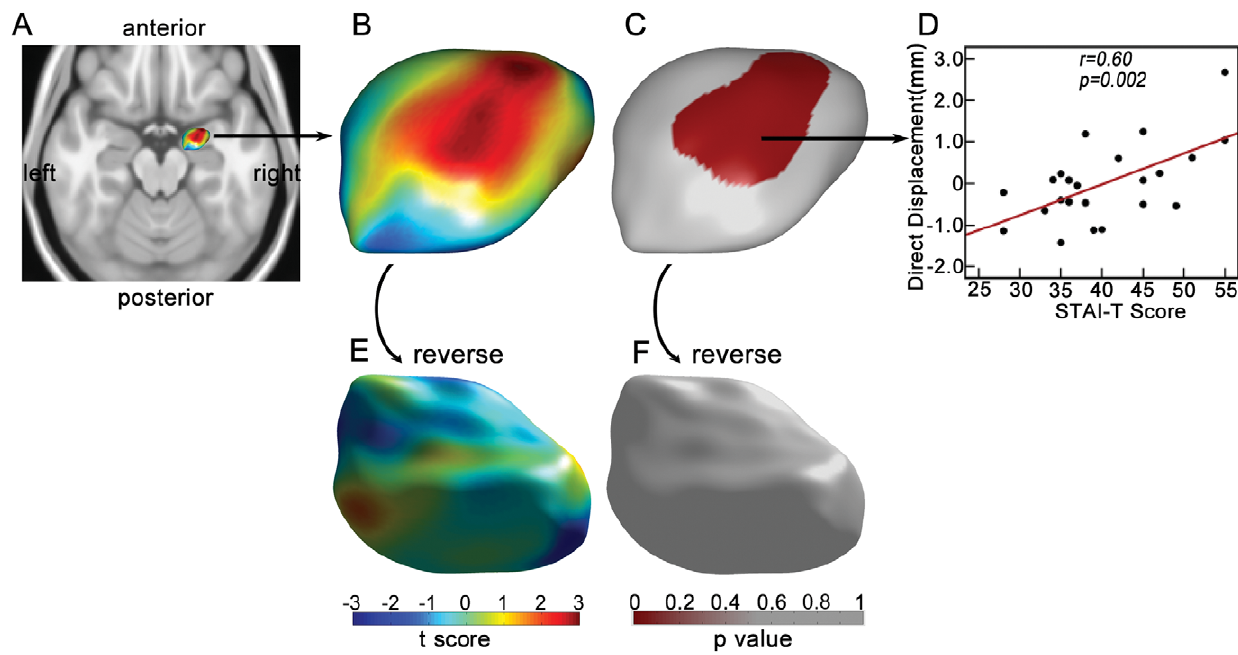
Figure 3. The correlation between direct displacement and trait anxiety. A) The rendering of right amygdala. The figure is shown from direction of superior to inferior. B) Dorsal view of T-statistic map for correlation between direct displacement of right amygdala and STAI-T scores. C) Dorsal view of P-statistic map. Only significant surface clusters (p=0.037, cluster-level, corrected) are colored. Only one cluster (red) was survived as shown. D) The scatter plot showing averaged direct displacement within the surface cluster versus STAI-T score. The red line is the regression line. E) Ventral view of T-statistic map. F) Ventral view of P-statistic map. Notably, left amygdala was not shown because no significant results were found.